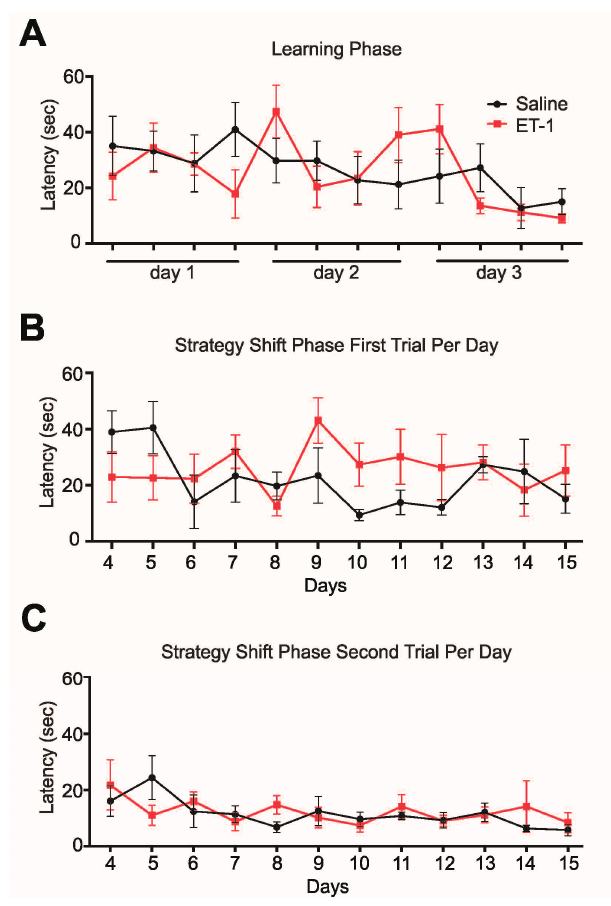
Figure 3. Assessments of executive function in the Morris Water Maze. ( A ) Both experimental groups learn to find the fixed hidden platform equally well across 12 learning trials, starting on day 7 p.i.; ( B ) Performance in the first trial of each day’s strategy shift protocol, when the platform was located in a new position, indicates no significant difference in performance between experimental groups; and ( C ) Performance on the second trial per day indicates no difference between the groups in the ability to recall the platform location from 30 s